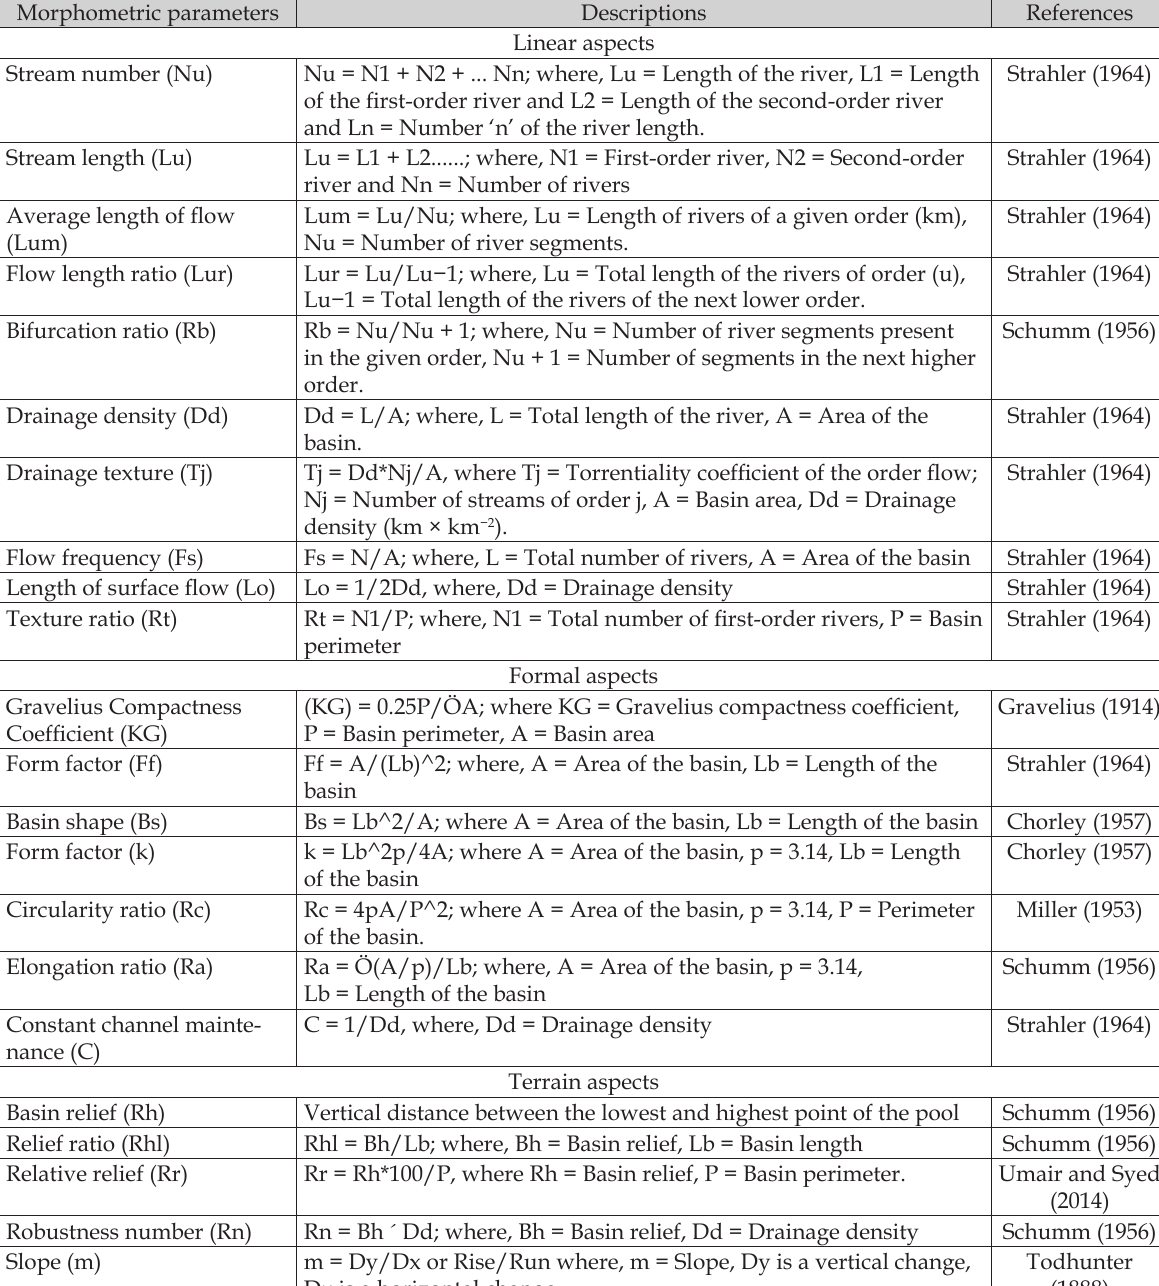
Table 1. Morphometric